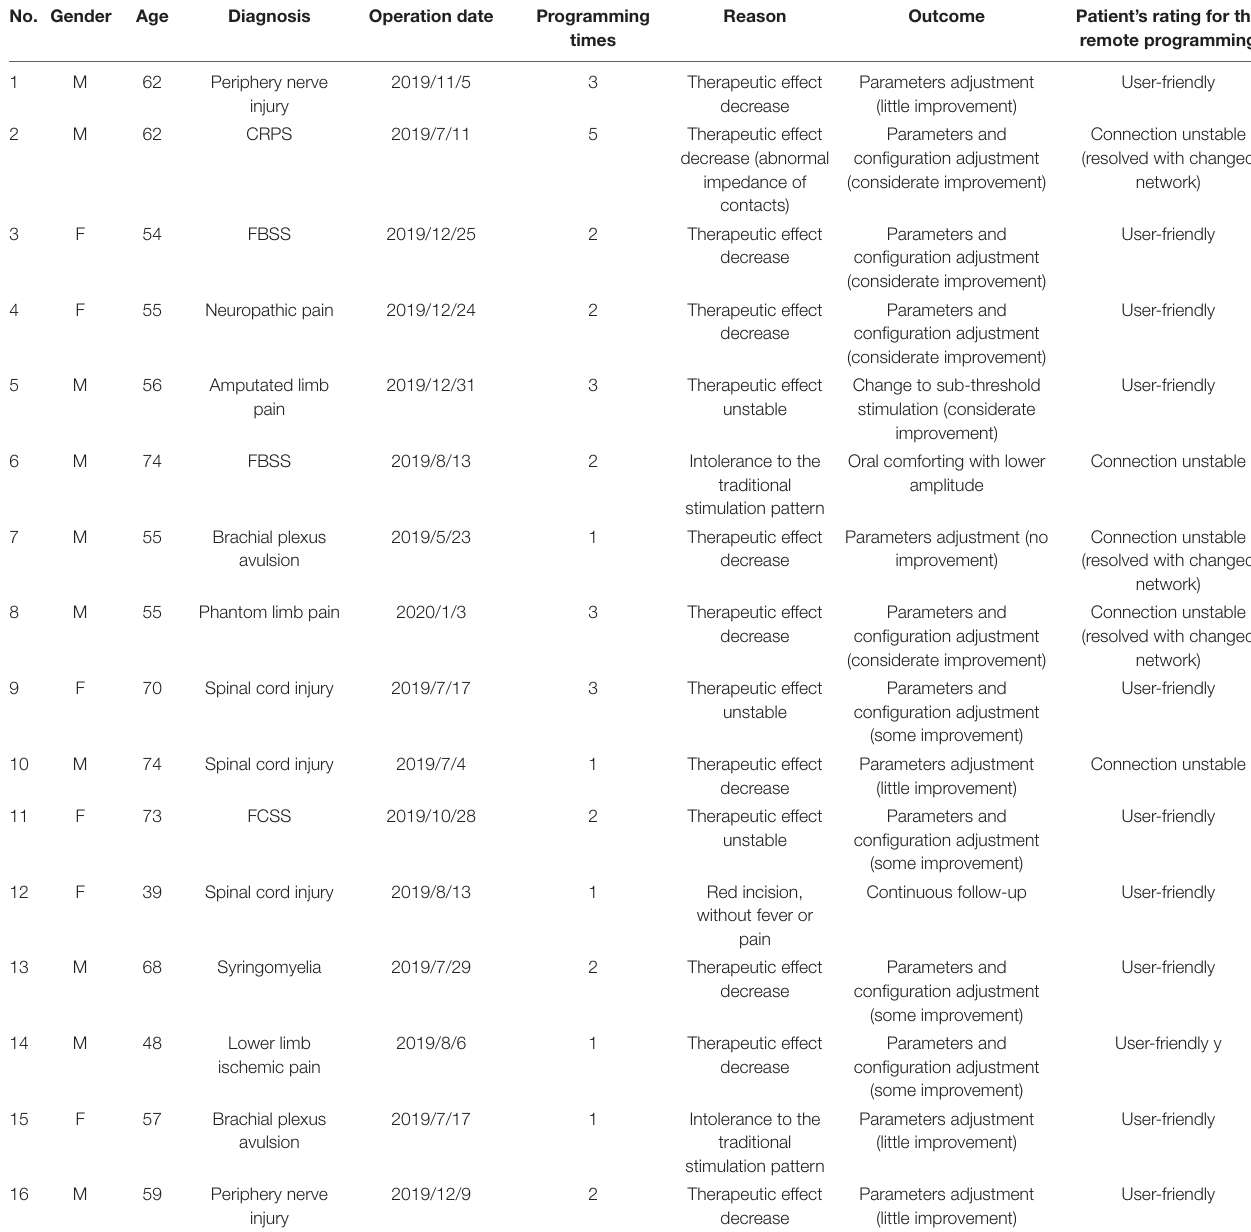
TABLE 1 | Characteristics of the 16 patients who received remote programming during the COVID-19 pandemic. No. Gender